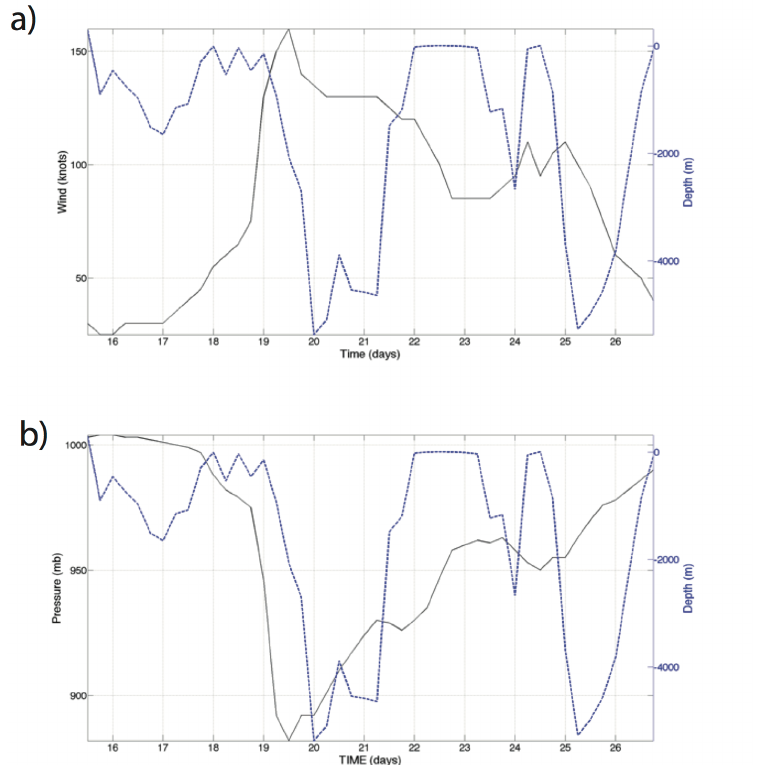
Figure 11. Category-5 Hurricane Wilma (2006). ( a ) This is an example of the analysis of the category-5 hurricane Wilma wind speed and bathymetry. It reaches its maximum speed (black line) around the greatest depth ( − 4500 m; dotted blue line). ( b ) It is also possible to analyze the atmospheric pressure data for the same example of Wilma. It reaches its minimum pressure (black line) around the greatest depth ( − 4500 m; dotted blue